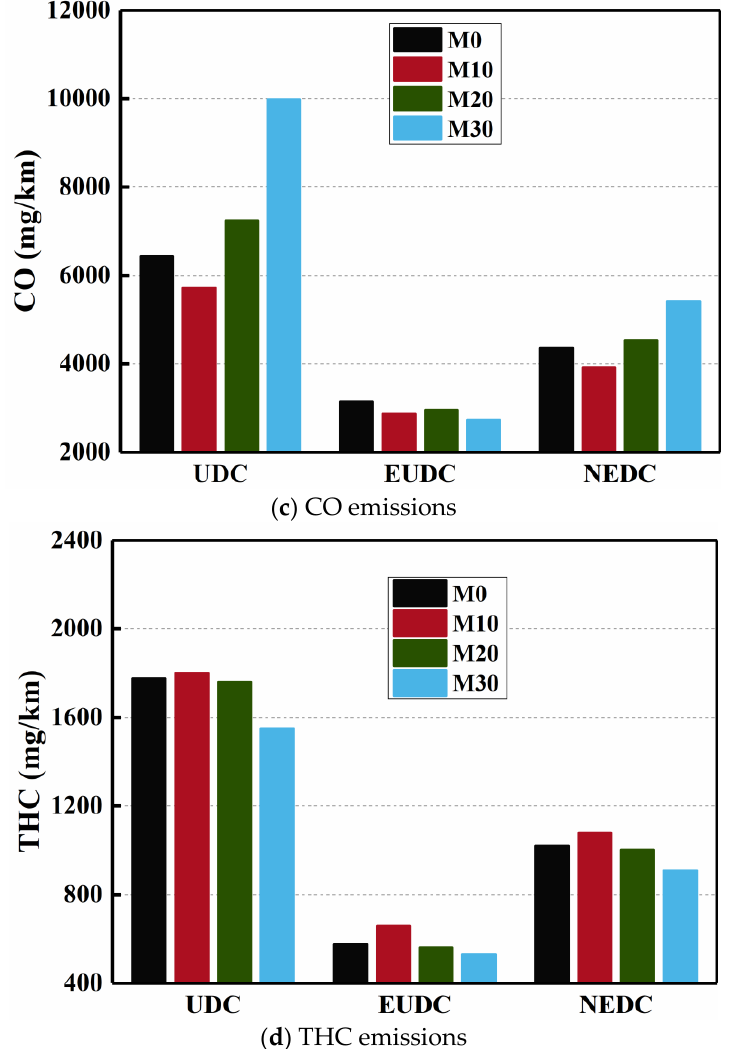
Figure 9. Effects of different methanol blending ratios on gaseous emissions under NEDC.